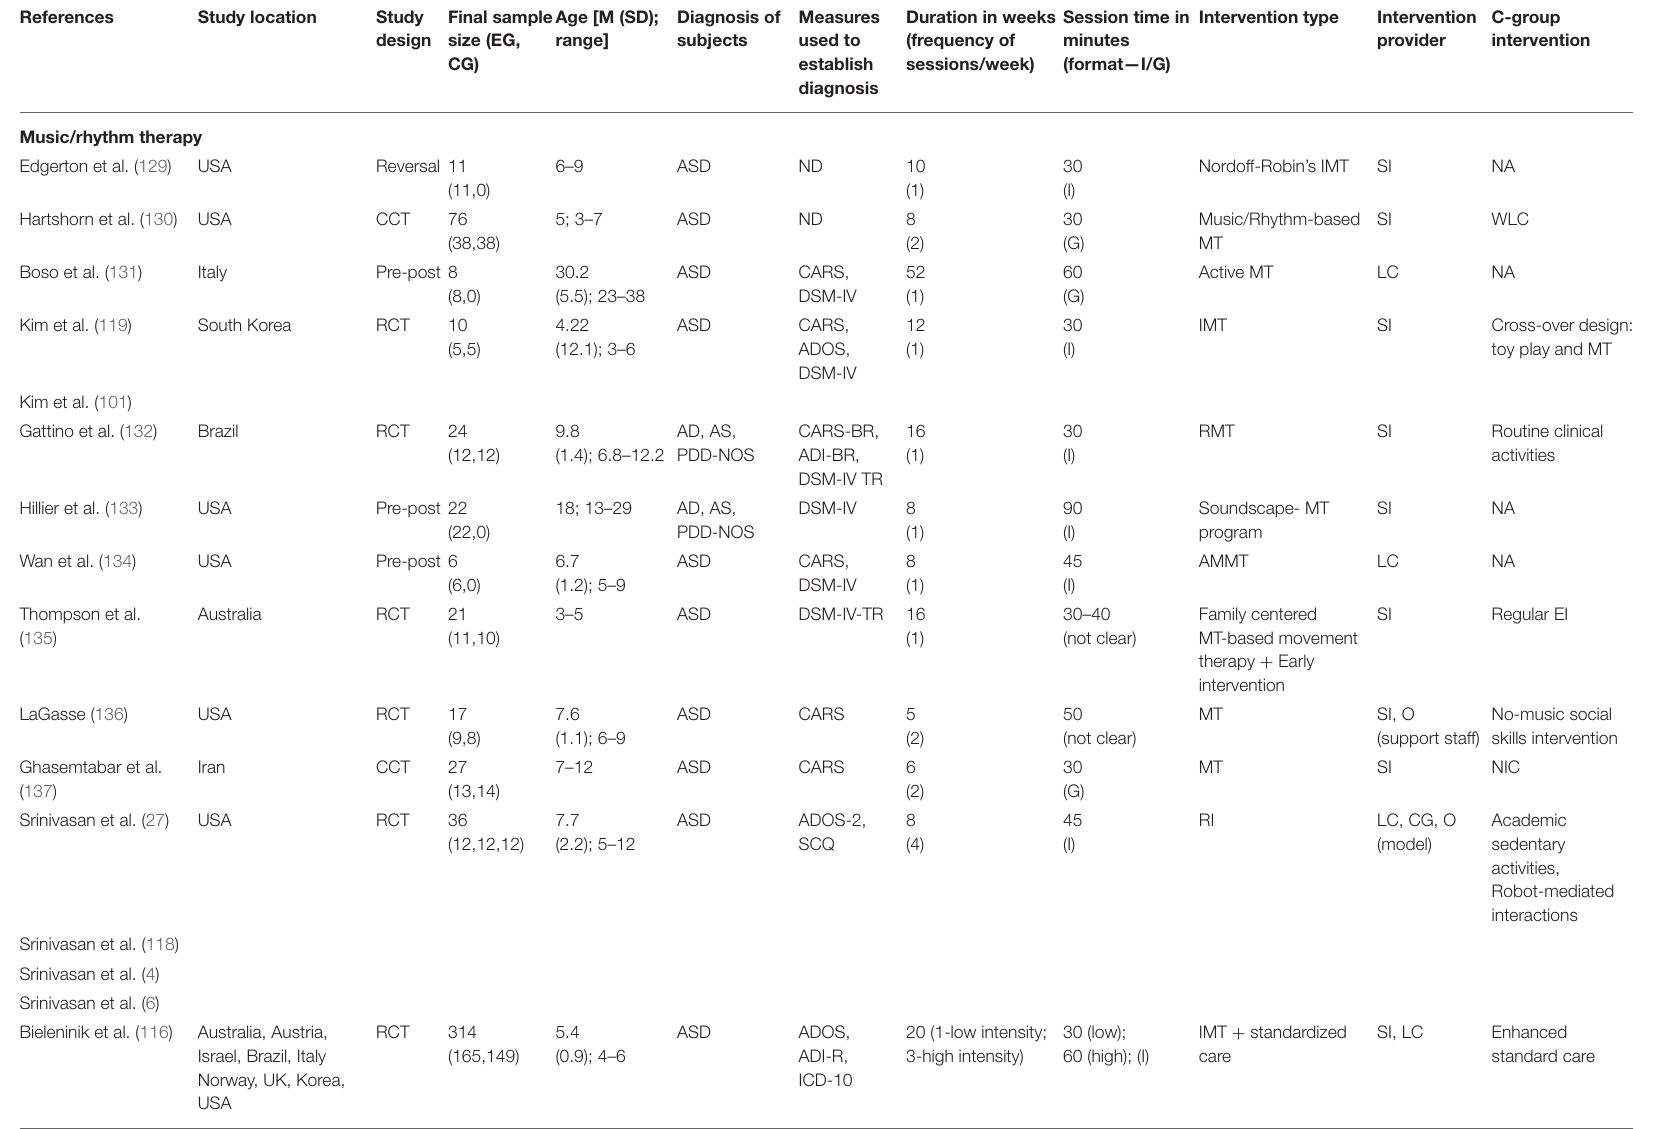
TABLE 1 | Study and sample